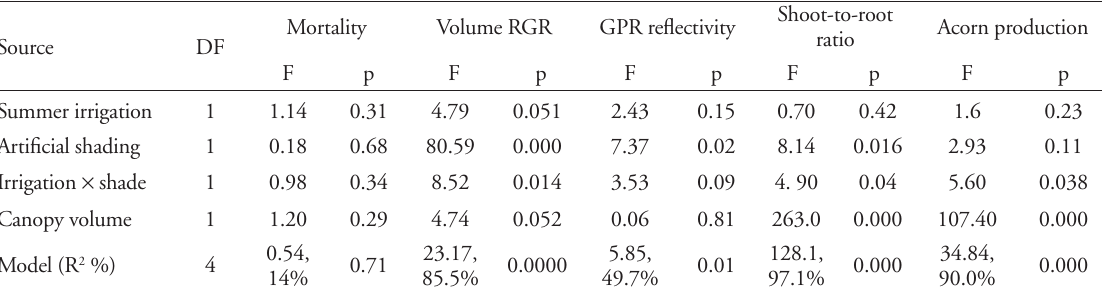
Table 1. Results of the ANCOVA models used to test for the effects of previous environmental conditions (summer irrigation and artificial shading applied for three years) and canopy volume on several performance attributes of Quercus ilex trees during the post- management period. Error DF are 11.